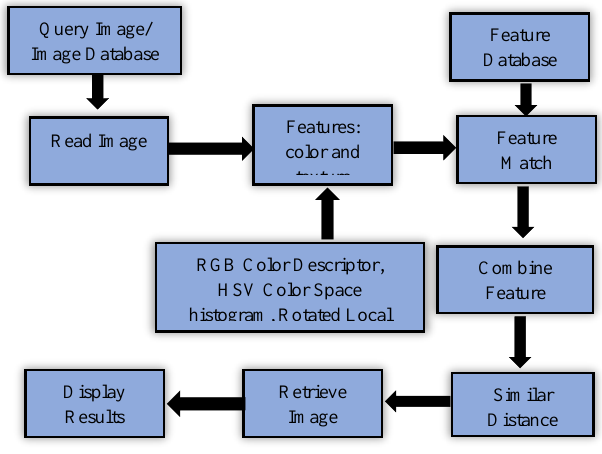
Fig. 2. Workflow of Proposed CBIR using Rotated Local Binary Pattern